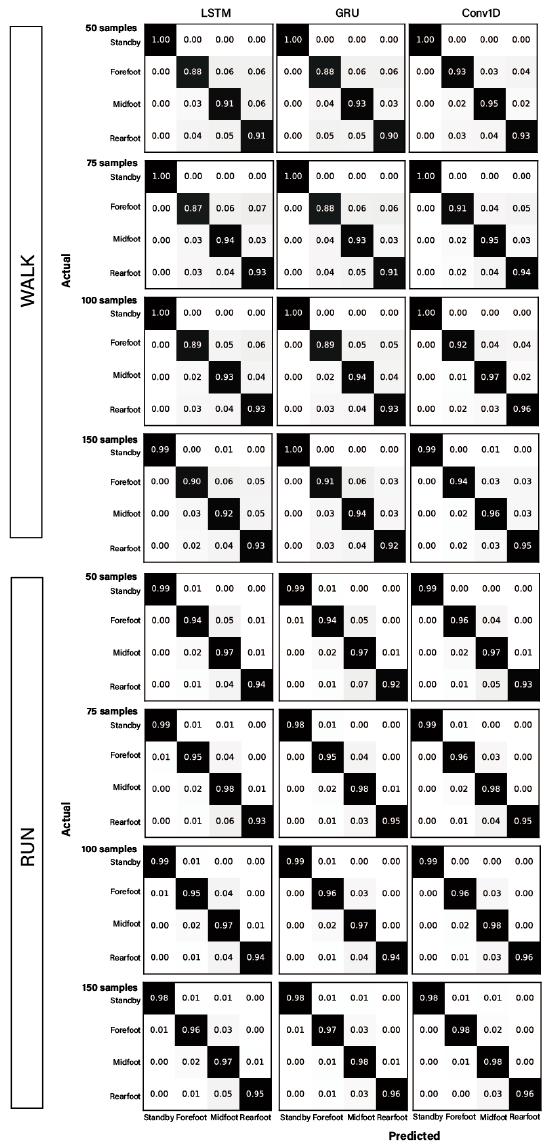
Figure A1. Normalized confusion matrices when deep neural network-based classifiers were em- ployed for classifying the walking data and running data.